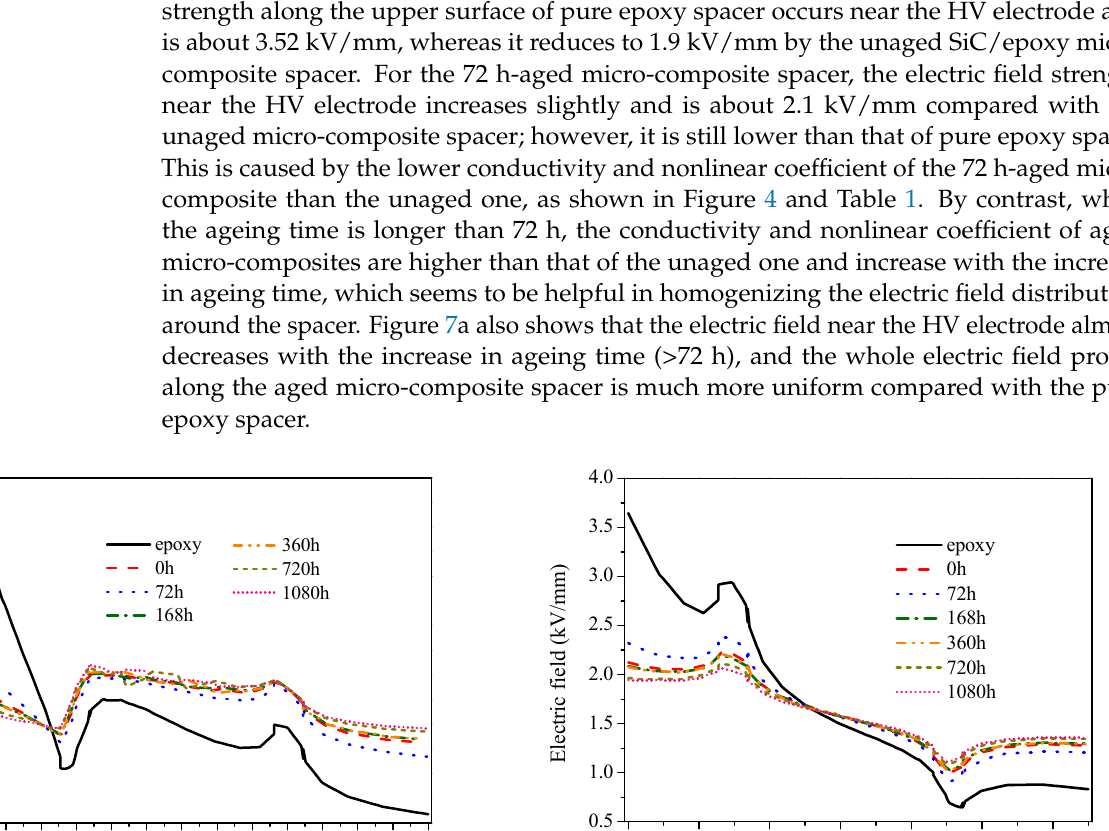
Figure 7. Electric field profile along the upper (i.e., Path #1) and lower (i.e., Path #2) surfaces of pure epoxy and aged SiC/epoxy micro-composite spacer: ( a ) Upper surface; ( b ) Lower surface.